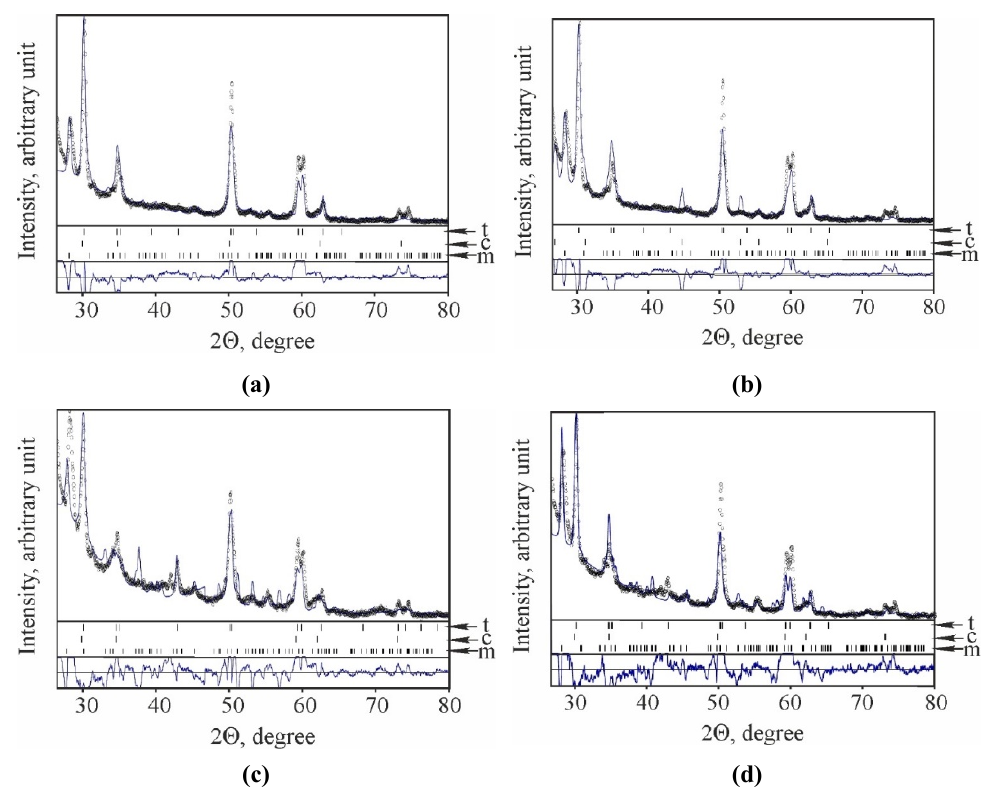
Figure 2. XRD patterns of the investigated materials of variants ( a ) 6YSZ ‐ 1550, ( b ) 6YSZ ‐ 1600, ( c ) 7YSZ ‐ 1600, and ( d ) 8YSZ ‐ 1600 (see Table 1). Phase marking: t—tetragonal, m—monoclinic, c—cubic.